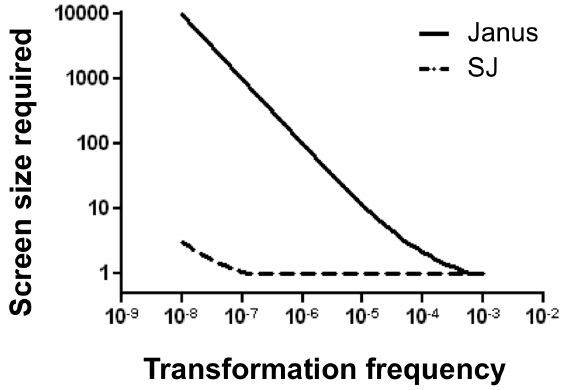
Figure 2. SJ allows more efficient identification of true transformants. Screen size (number of colonies on the selection plate to be examined after transformation) that would allow 95% probability of finding at least one true transformant (Km s ) among revertants (Km r ) at indicated transformation frequency was calculated for Janus (solid line) and SJ (dashed line). The observed revertant frequency during transformation of Janus and SJ (Table 3) was used in screen size calculation (see Materials and Methods for calculation details).